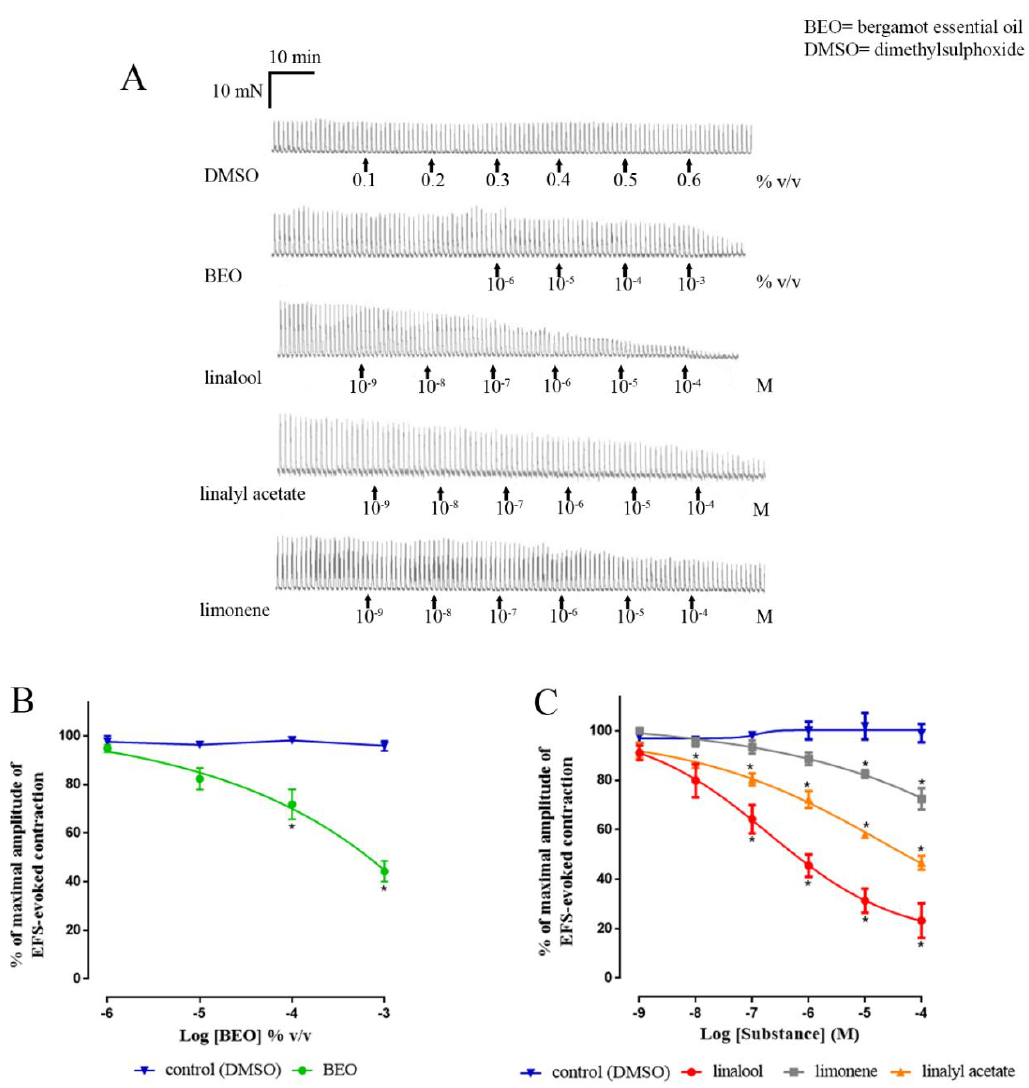
Figure 2. E ff ect of bergamot essential oil (BEO) and its major components on EFS-evoked contractions in human isolated colon. The examples of experimental records illustrating the pharmacology of responses are showed in panel ( A ). Panel ( B ) shows the concentration–response curves determined by BEO, and panel ( C ) shows the combination of all results obtained with linalool, linalyl acetate, limonene. Note that the values for BEO, an oil, are given as volume / volume of bathing solution, whereas the concentrations of the individual compounds are given as molar values. Each point represents the mean of patients studied: DMSO n = 4, BEO n = 5, linalool n = 4, linalyl acetate n = 4, limonene n = 3. The cumulative concentration-e ff ect was determined by combining data obtained from both regions of colon (ascending + descending) and were fitted by non-linear regression to a four-parameter Hill equation. Vertical lines show standard error of mean. EFS (5 Hz, pulse width 0.5 ms, for 10 s every 1 min). EFS = electrical field Ssimulation. * p ≤ 0.05 versus control ( t- tests).